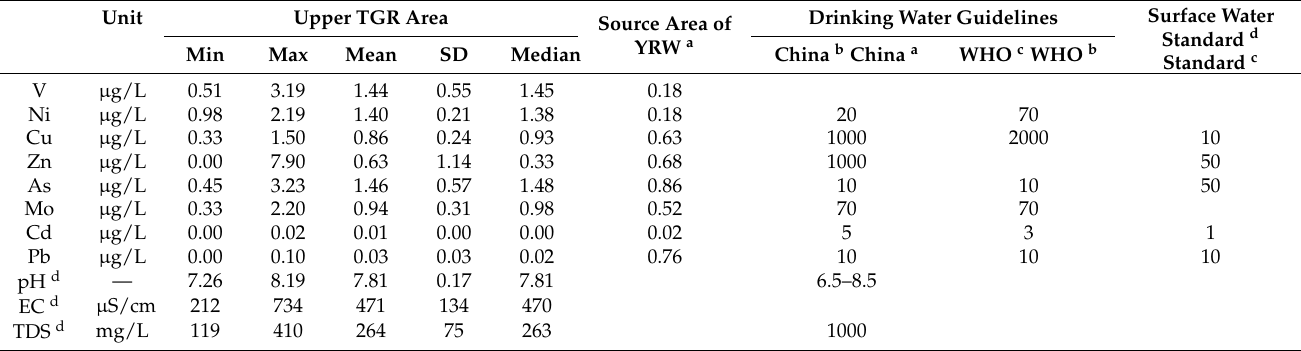
Table 2. HM concentrations, pH, electric conductivity, and total dissolved solids of river water in the upper TGR area and related limit values of drinking water